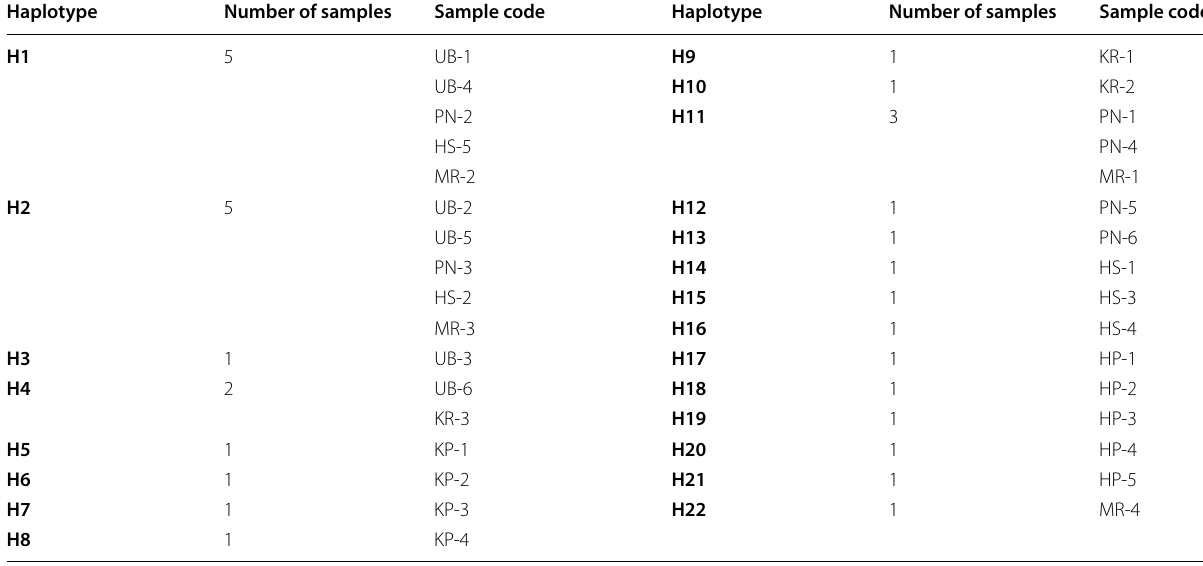
Table 4 Haplogroup of Cynopterus brachyotis from seven habitats on Java island based on mitochondrial DNA